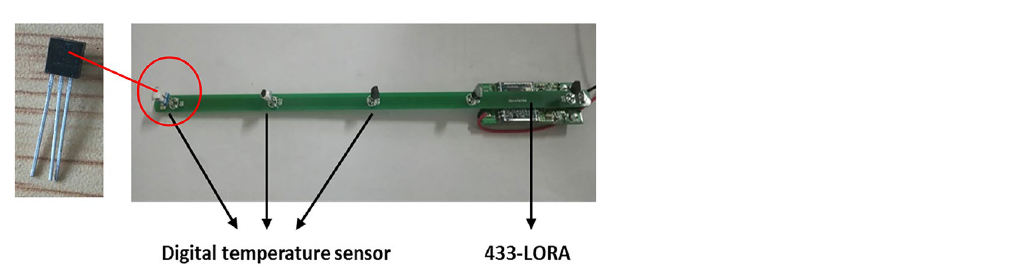
Figure 3. The integrated sensor